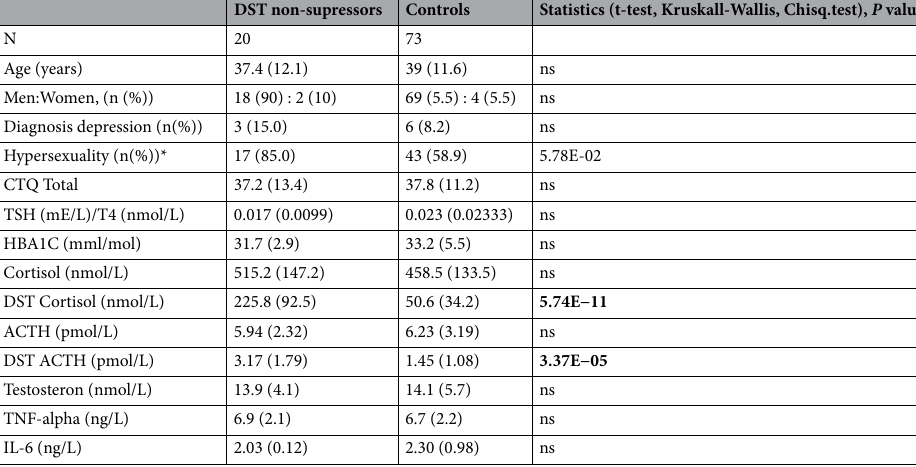
Table 1. Clinical characteristics of DST non-suppressors and controls. Values are shown as mean (SD) unless otherwise specified. P-values were calculated by means of t-test, Kruskall-Wallis’ test or chi-squared tests, contrasting values for DST non-suppressors and controls (DST suppressors). A one-tailed p-value < 0.05 was considered significant. CTQ childhood trauma questionnaire, DST ACTH ACTH levels after the dexamethasone suppression test, DST Cortisol cortisol levels after the dexamethasone suppression test; DST non-suppressors, non-suppression status defined as DST cortisol levels ≥ 138 nmol/l, ns not